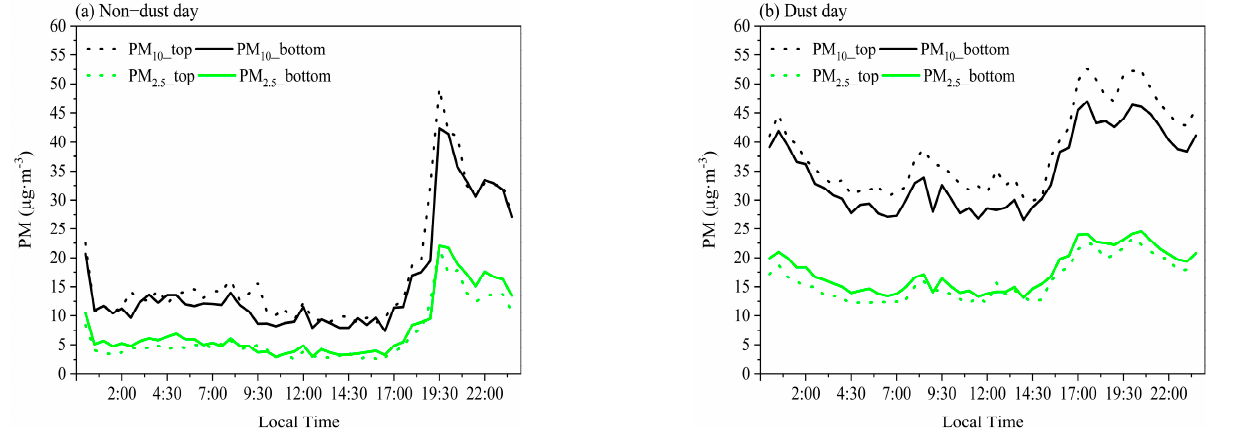
Figure 5. Mean diurnal variations in dust concentrations on the non-dust and dust weather during observation in the TD.